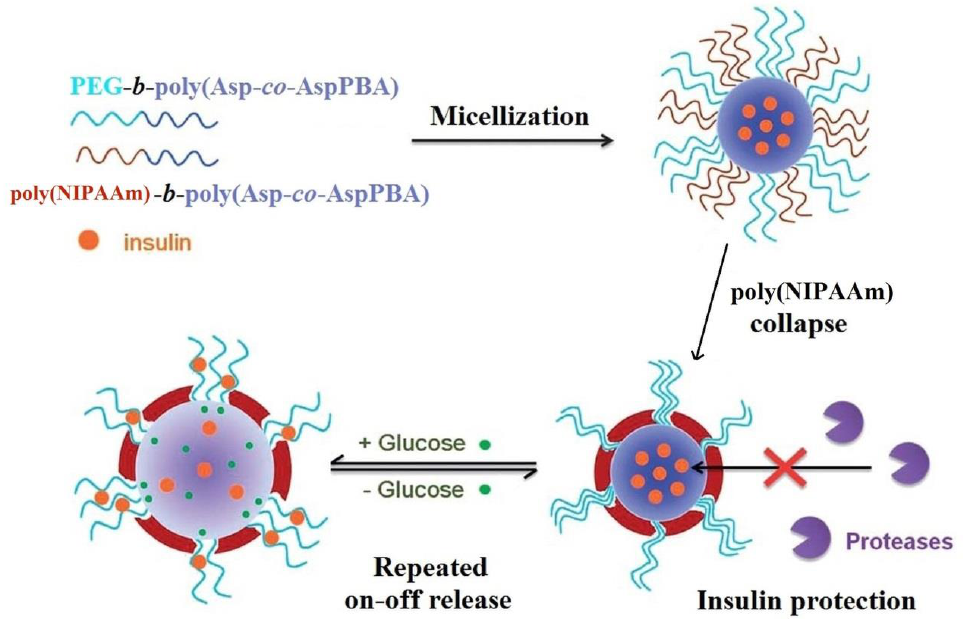
Figure 9. Formation of glucose-responsiveness polymeric micelles based on two diblock copolymers which exhibit a reversible swelling in response to the change of glucose concentration and insulin protection under physiological conditions (Adapted from reference [90] with permission from the Royal Society of Chemistry).